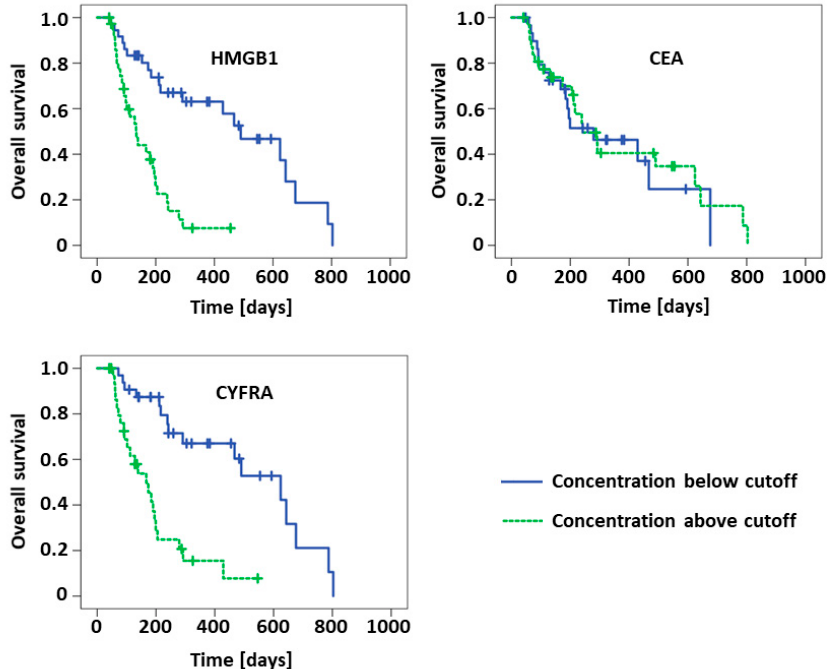
Figure 4. Kaplan–Meier curves of NSCLC patients possessing concentrations of high mobility group box 1 protein (HMGB1), carcinoembryonic antigen (CEA) and cytokeratin 19-fragments (CYFRA) below or above the respective cutoff values at the third chemotherapy cycle.